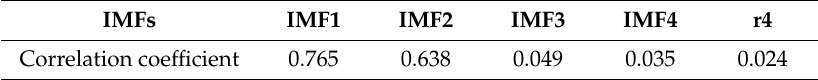
Table 3. The correlation coefficients between each IMF and the original